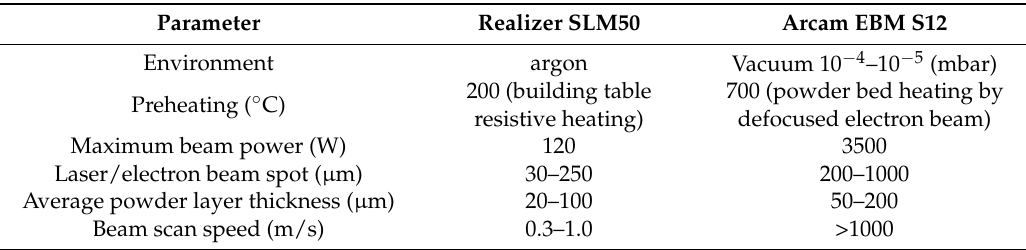
Table 1. A comparison between the .Realizer SLM50 (Selective Laser Melting) and the Arcam EBM S12